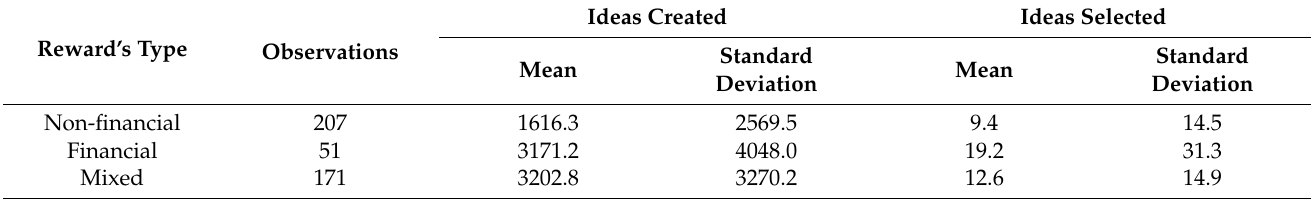
Table 8. Descriptive statistics on ideas created and selected by the rewards’ types.